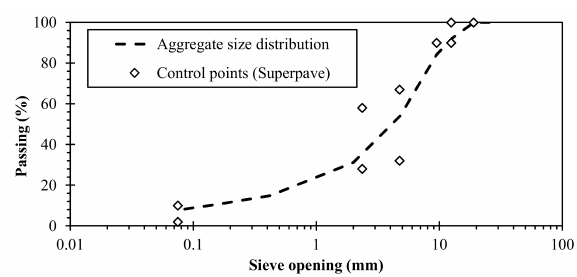
Figure 1: Aggregate size distribution